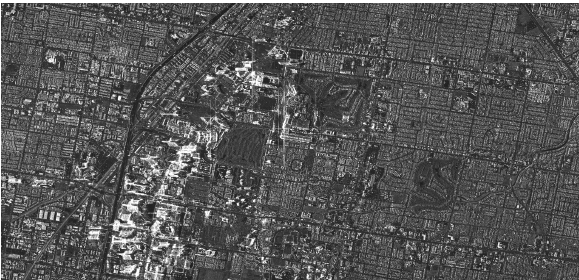
Figure 9: Master channel amplitude of the high resolution spot- light acquisition acquired over Las Vegas on the 25th September, 2011.